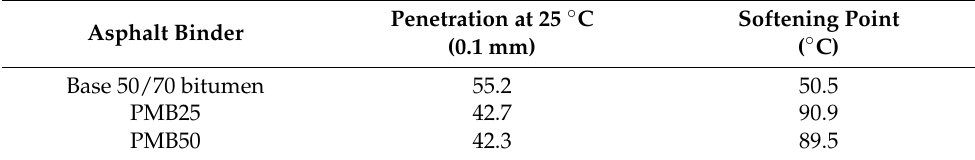
Table 3. Penetration and softening point properties of the studied asphalt